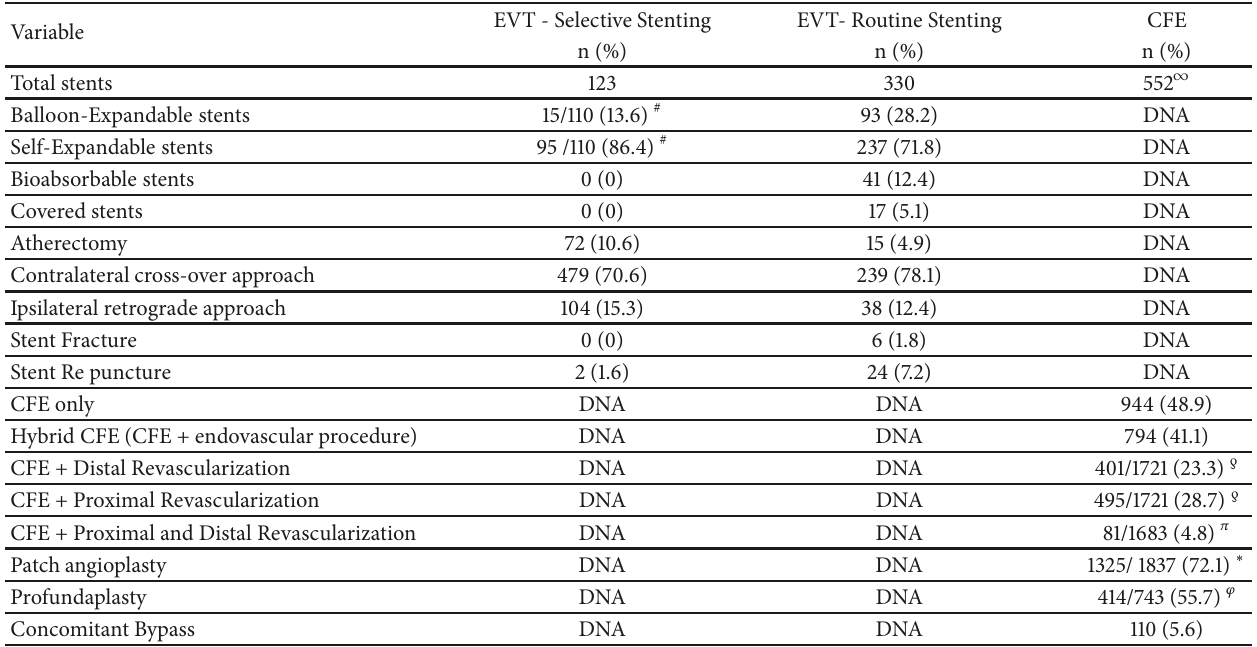
Figure 2: Forrest plot for PP (Primary patency) at 1 year in EVTSS (Endovascular therapy with selective stenting) group. Table 3: Procedural details in different treatment